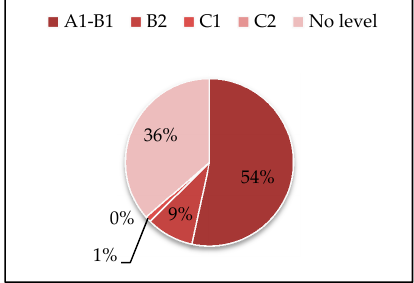
Figure 1. Respondents’ level of English certification.